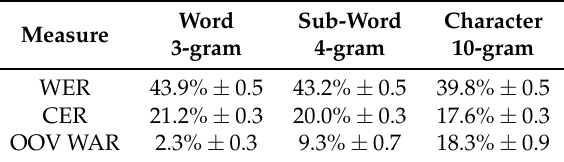
Figure 9. Results obtained by decoding at the HMM character level by using n -gram language models with size n = { 1, . . . ,15 } . Overall best results on the Rodrigo test set in terms of WER, CER and OOV WAR for the HMM